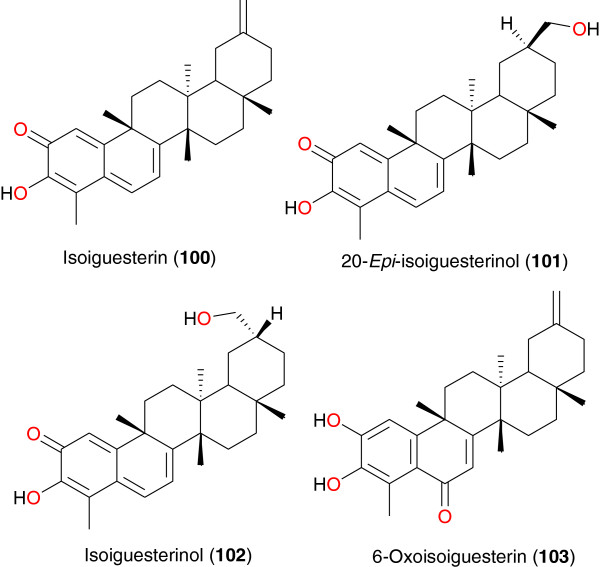
Bisnorterpenes from African medicinal plants with anti-malarial activity.